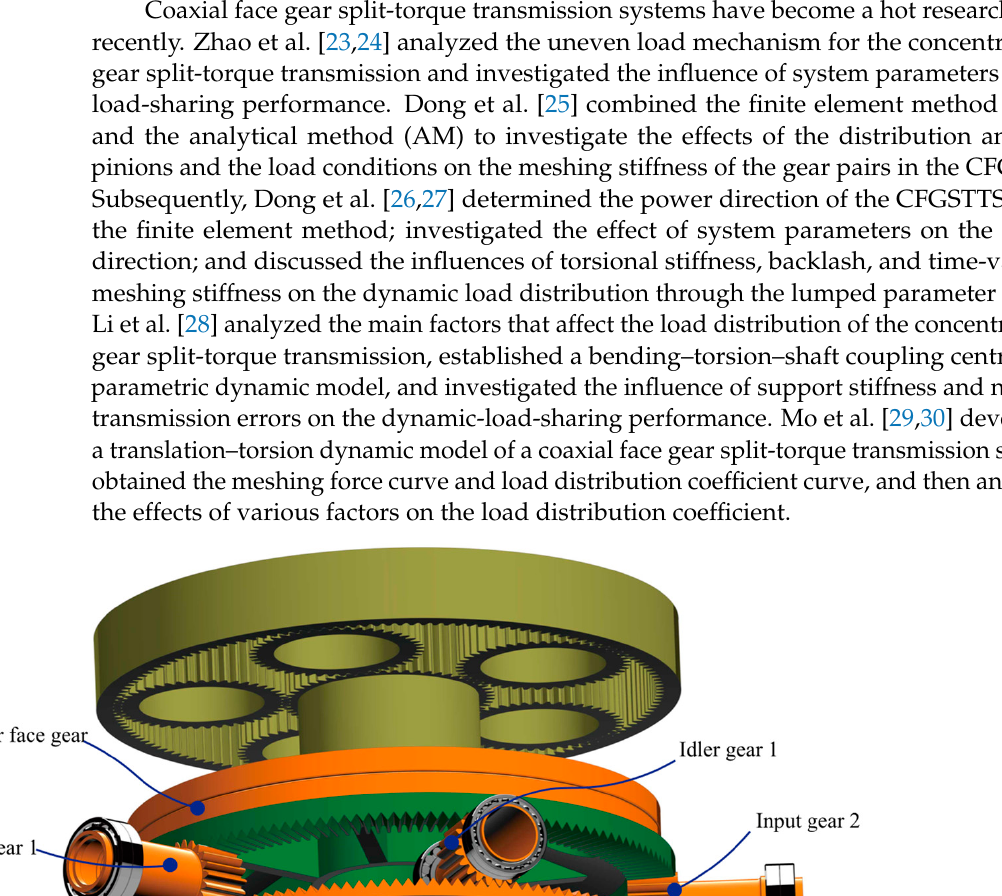
( b ) Figure 2. Diagrams showing the processing of the face gear: ( a ) parameters of the involute surface of the gear cutter and ( b ) generating coordinate system of face gear. The tooth surface Σ s of the spur gear cutter was established according to the involute equation as follows: 𝑟 (cid:3046) (𝑢 (cid:3046) , 𝜃 (cid:3046) ) = (cid:3421)(cid:3399)𝑟 (cid:3029)(cid:3046) (sin(𝜃 (cid:3042)(cid:3046) + 𝜃 (cid:3046) ) − 𝜃 (cid:3046) cos(𝜃 (cid:3042)(cid:3046) + 𝜃 (cid:3046) )) −𝑟 (cid:3029)(cid:3046) (cos(𝜃 (cid:3042)(cid:3046) + 𝜃 (cid:3046) ) + 𝜃 (cid:3046) sin(𝜃 (cid:3042)(cid:3046) + 𝜃 (cid:3046) )) 𝑢 (cid:3046) (1) where u s and θ s are the tooth surface parameters of the cutter gear; 𝑟 (cid:3029)(cid:3046) is the radius of the base circle; ‘ (cid:3399) ’ represents the involutes 𝛾 − 𝛾 and 𝛽 − 𝛽 , respectively; and 𝜃 (cid:3042)(cid:3046) is ex- pressed as: